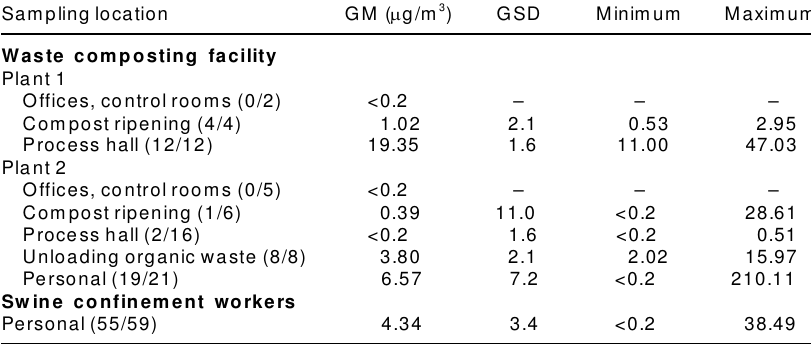
Table 1. (1 ® 3)- b - D -glucan exposure measurements in two occupational environments (glucan detectable/total samples) Sampling location